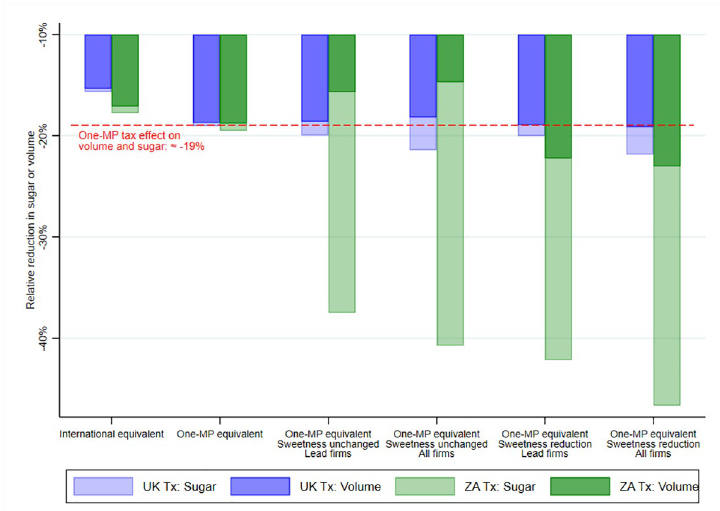
Fig 3. Tax effect in 2014 and 2015 by tax design. MP: Mexican peso. UK: United Kingdom. ZA: South Africa. Source : Authors’ own analyses and calculations based on data from Nielsen through its Mexico Consumer Panel Service (CPS) for the food and beverage categories for January 2012 –December 2015. The Nielsen Company, 2016. Nielsen is not responsible for and had no role in preparing the results reported herein.